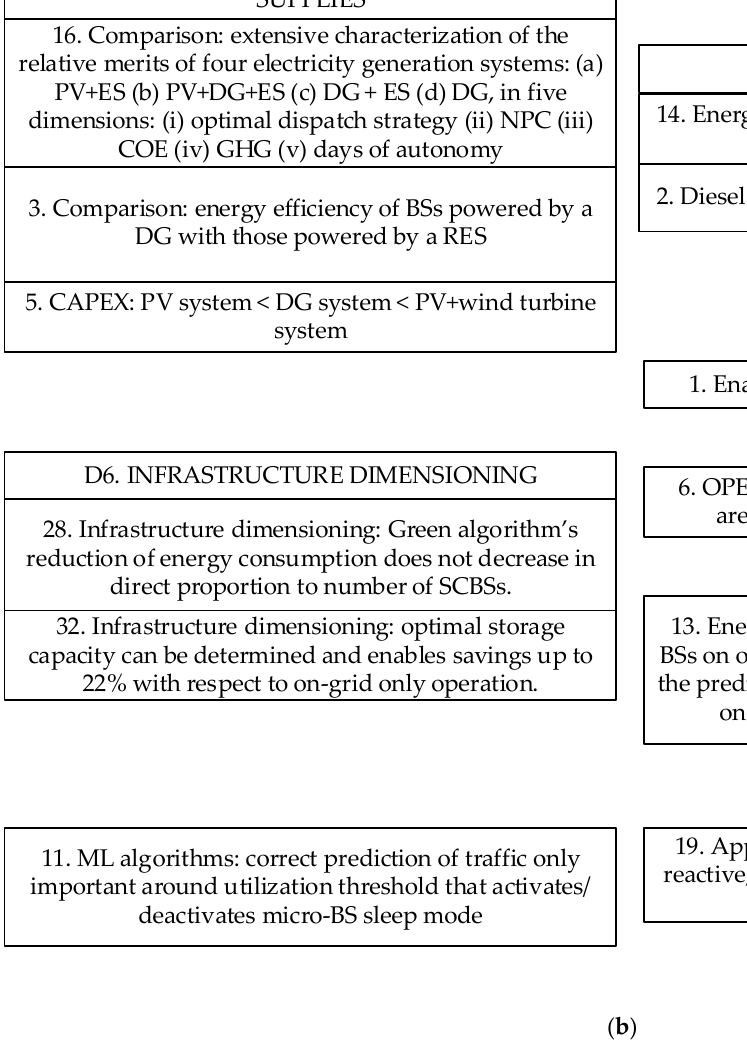
Figure A3. ( a ) A first categorization of the development nodes. ( b ) A first categorization of the de-